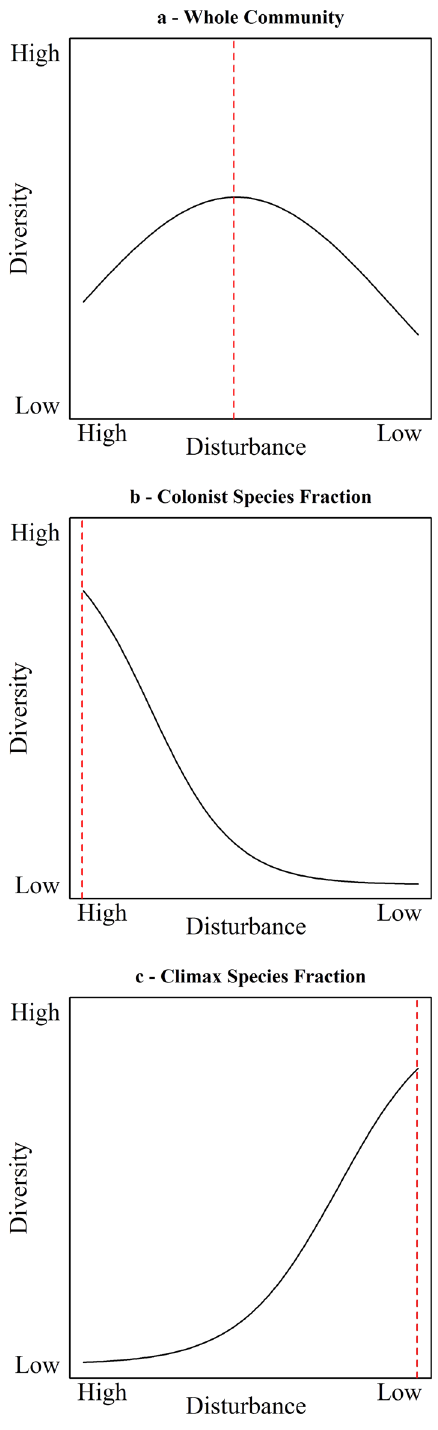
Figure 1. ( a ) The original IDH proposition made by Connell 1 . The author 1 considered diversity of a given community to be the highest at intermediate disturbance because of co-occurrence of colonist and climax species in the middle of disturbance gradient. From Connell 1 we derived theoretically that expected diversity of ( b ) Colonist species fraction peaks at high disturbance and that of ( c ) Climax species fraction peaks at low